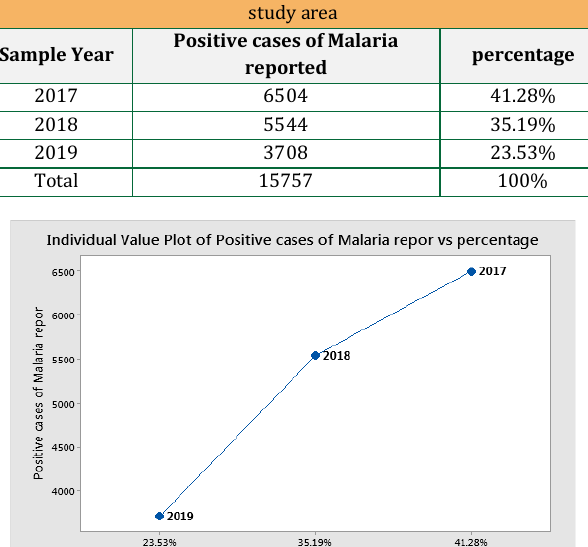
Table 5: Total Annual Average of the prevalence of Malaria in the